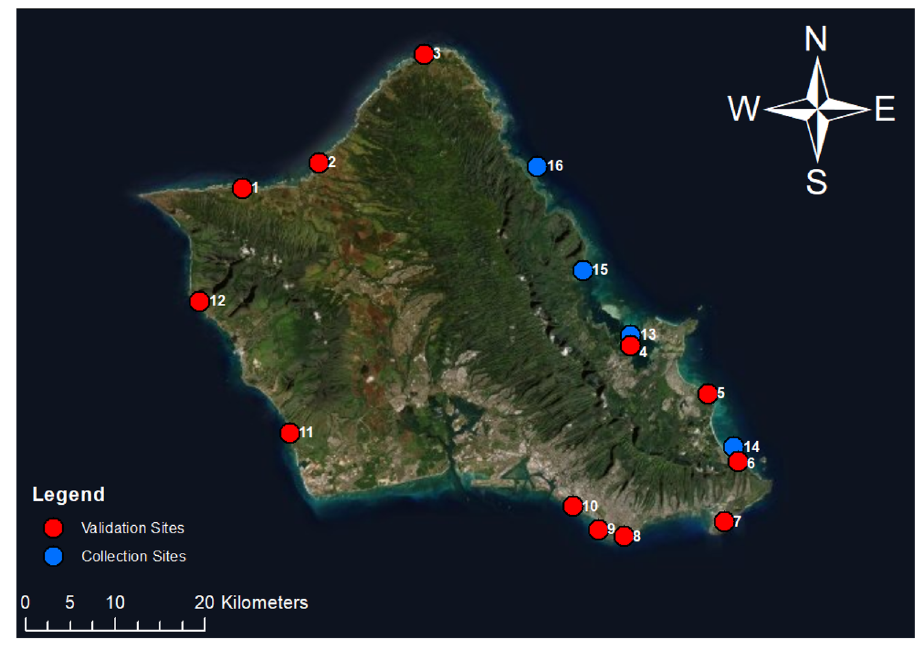
Fig. 3 A map of field validation (red) and collection sites (blue) on O‘ahu, Hawai‘i, including: 1. Mokulē ʻ ia, 2. Hale‘iwa,